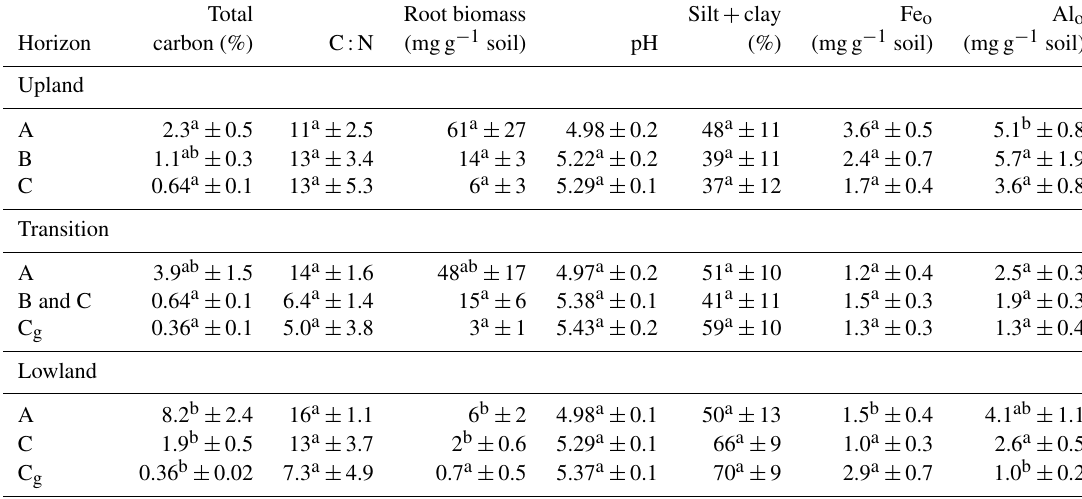
Table 3. Average ( n = 6 ± standard error) soil properties along the upland–lowland transect. Total Root biomass Silt + clay Fe o Al o Horizon carbon (%) C:N (mgg − 1 soil) pH (%) (mgg − 1 soil) (mgg − 1 soil)